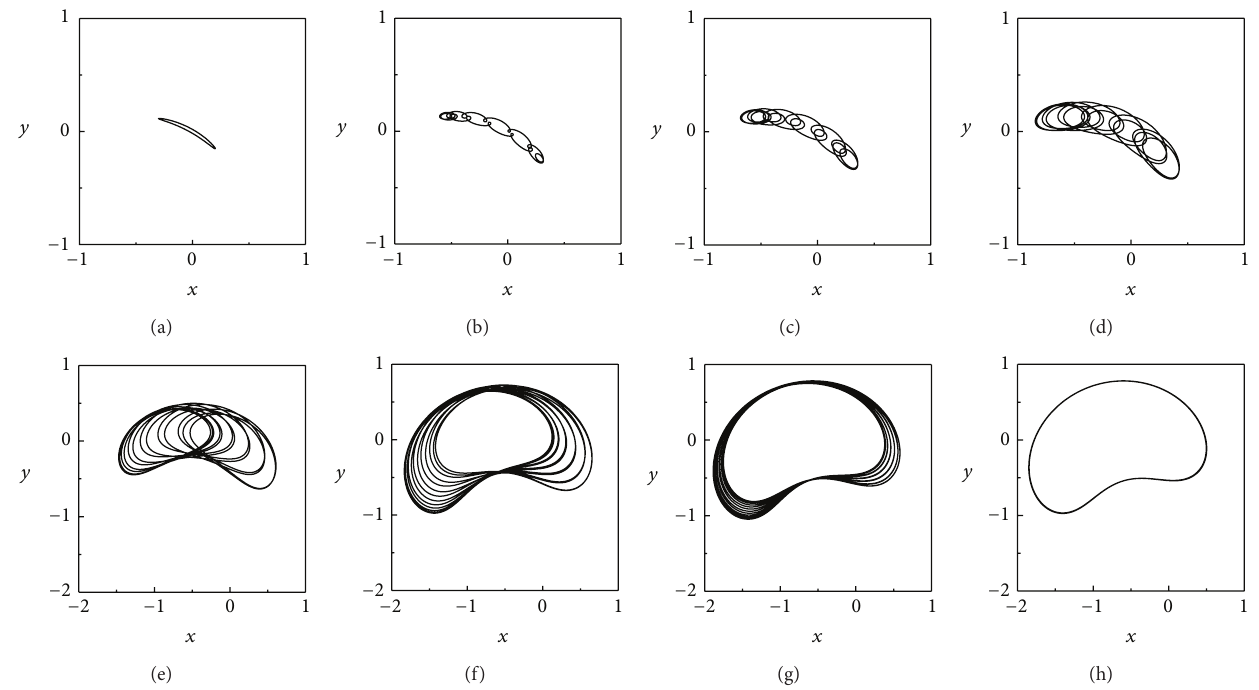
Figure 7: The evolution of the long period family 𝐿 13 by plotting sample periodic orbits. Note that the coordinate system has been transferred to the equilibrium point 𝐿 4